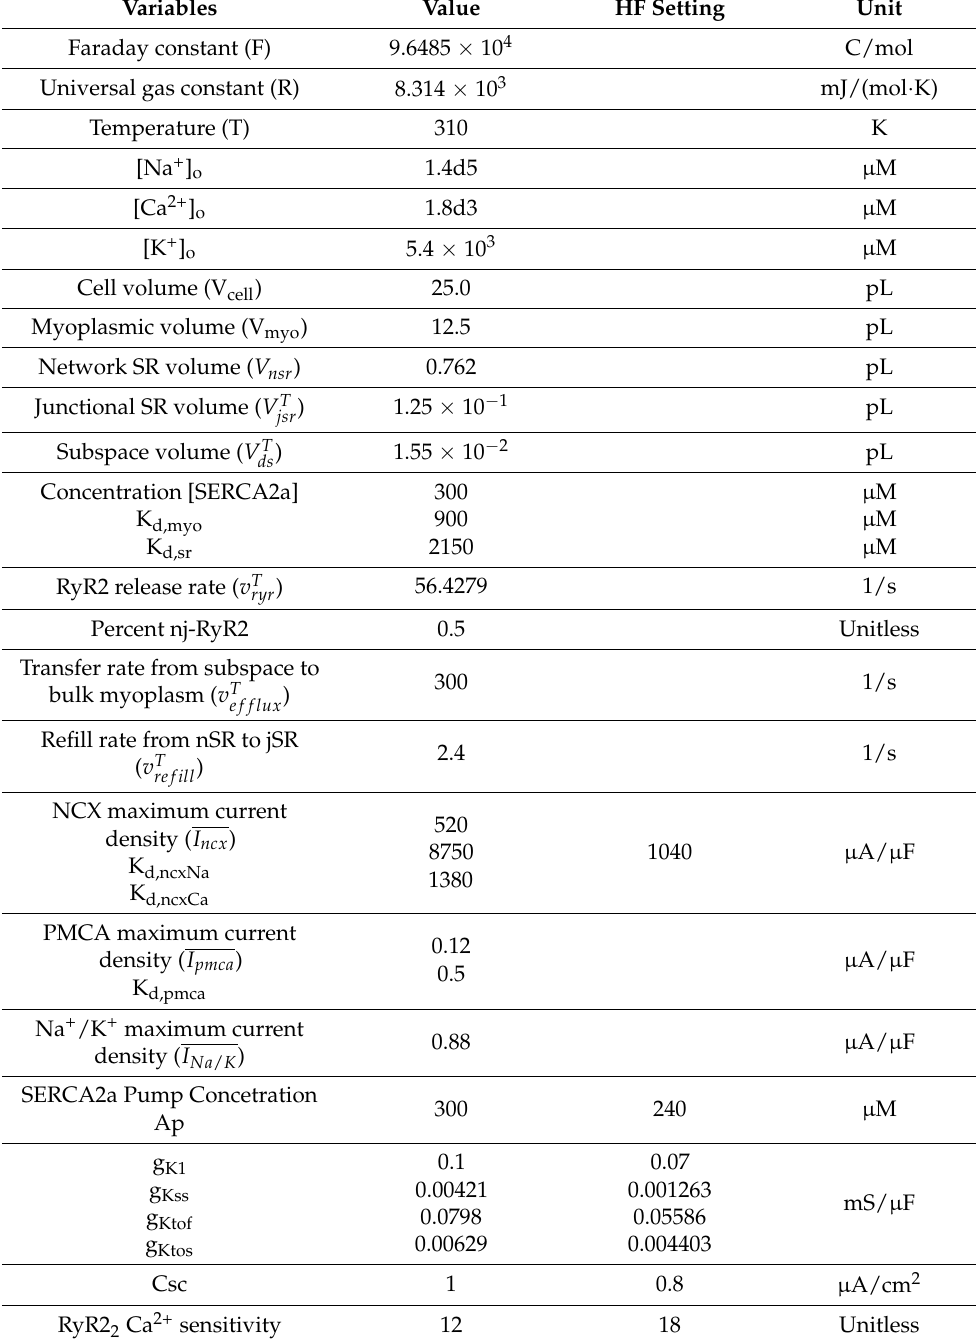
Table A1. Constant data and whole-cell level